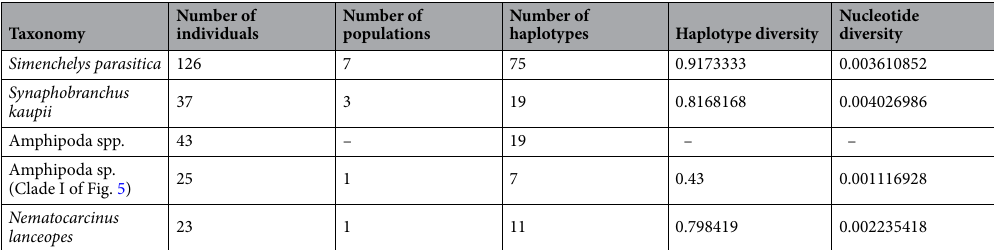
Table 2. Summary of genetic analysis results of non-vent animals across populations.